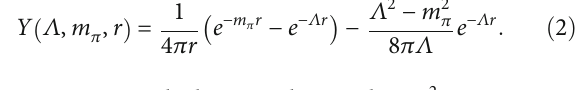
— — ð 4380 Þ and Λ = 800MeV c